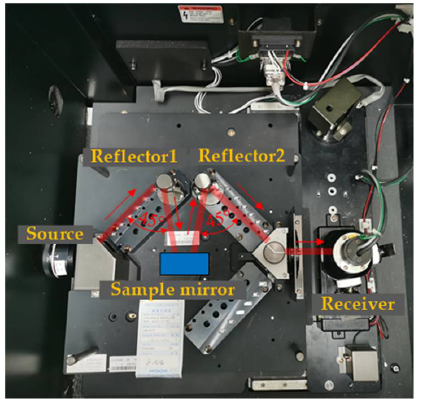
Figure 6. Experimental test of modified layer spectrophotometer.